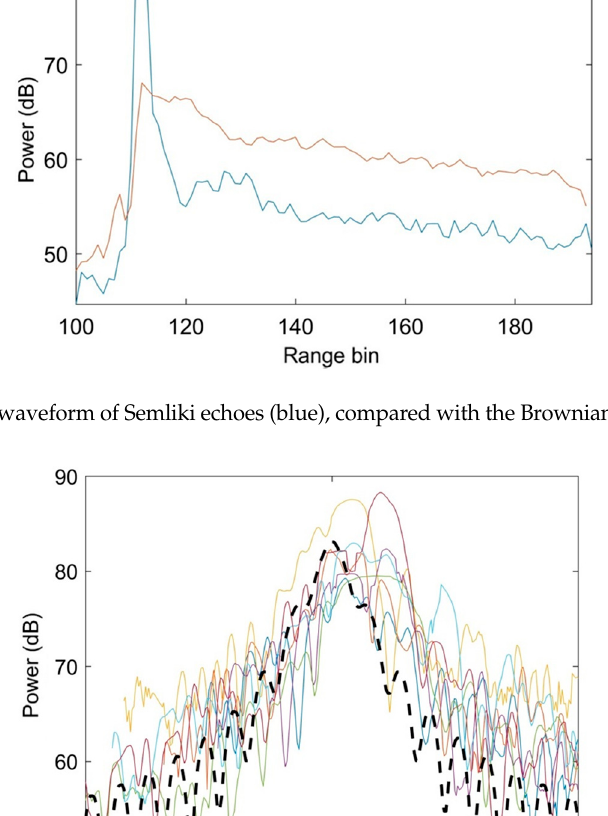
Figure 18. Doppler velocity from River Semiliki; dashed line is the theoretical Doppler. Different colors are used to distinguish between the different satellite passages.